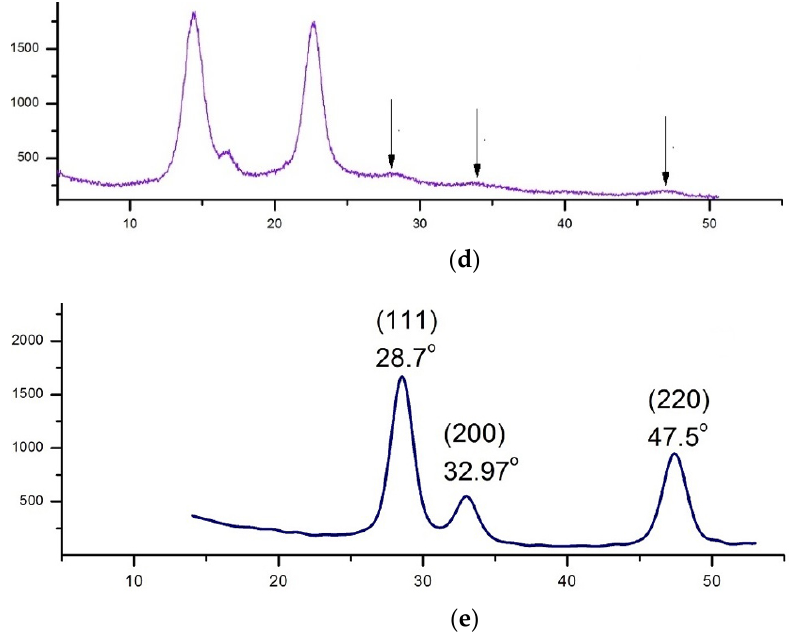
Figure 2. XRD patterns of the films: ( a ) bare BC; ( b – d ) BC-ceria nanocomposites with 1 wt.%, 3 wt.%, and 5 wt.%, respec- tively, ( e ) X-ray diffraction pattern of ceria nanoparticles. Arrows in XRD patterns of the composite samples indicate CeO 2 reflections.